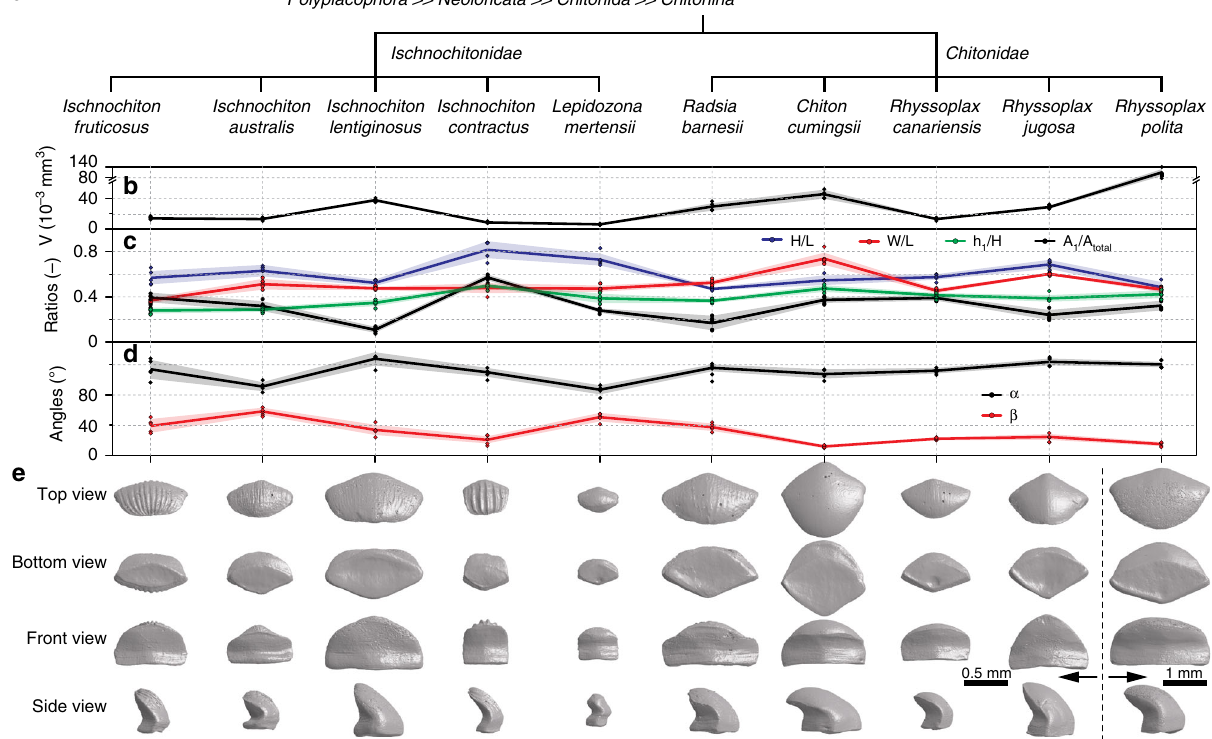
Fig. 4 Interspeci fi c comparison of the dorsal scale geometries among ten chiton species. a The phylogenetic distribution of the chiton species used in this study. Variations of morphological parameters, b volume, c length and area ratios, and d angles for different species. The solid line represents the average and the shaded area shows the standard deviations ( N = 5 for each measurement). e μ -CT data-based 3D reconstructions of individual dorsal scales from the ten chiton species in four different views: top, bottom, front, and side. All the reconstructions are at the same length scale except those from Rhyssoplax polita